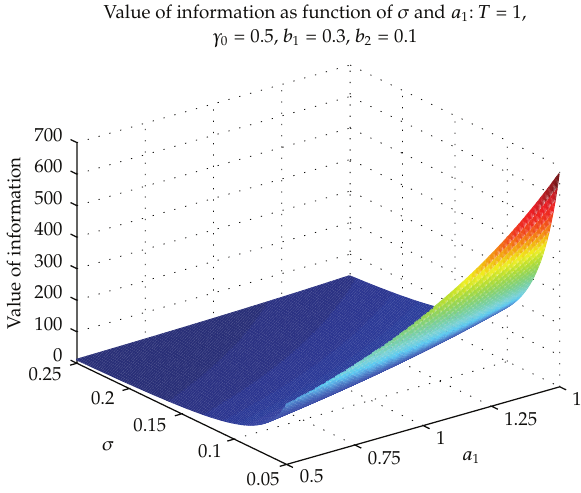
Figure 1: V as a function of σ and a 1